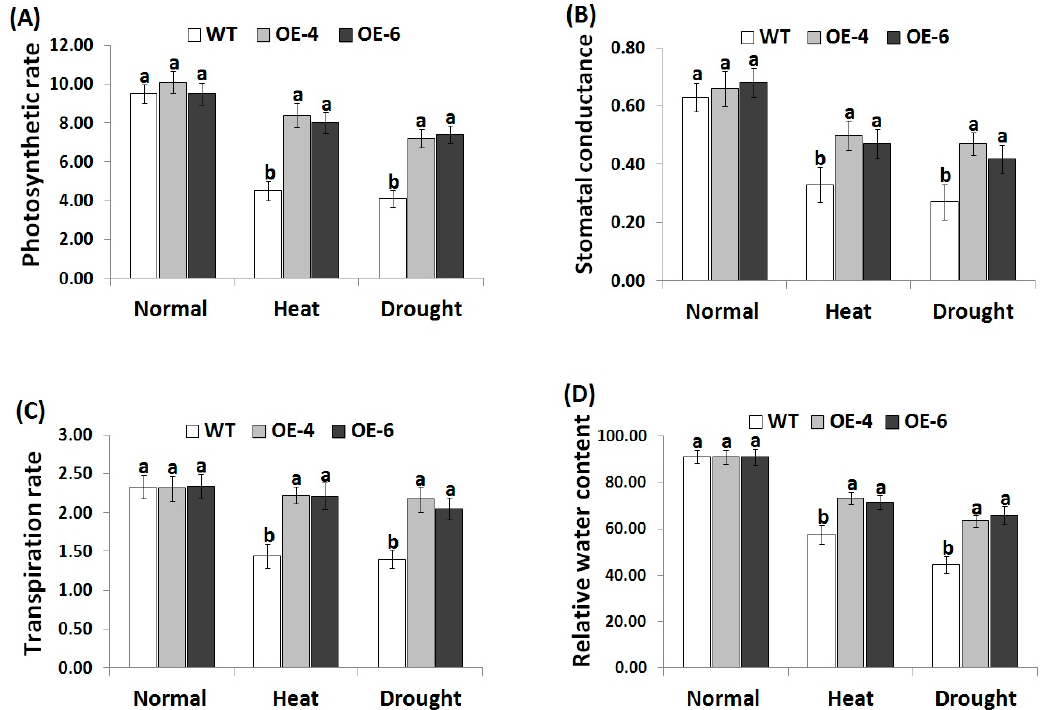
Figure 2. Photosynthesis rate ( P n , µ mol m 2 s − 1 ) ( A ), stomatal conductance ( g s , mol m 2 s − 1 ) ( B ), transpiration rate ( E , mmol m 2 s − 1 ) ( C ), and relative water content (RWC, %) ( D ) of the wild type and transgenic wheat genotypes under normal, heat, and drought stress treatments. Data indicate means ± SE ( n = 4). Different letters on the columns represent significant difference ( p ≤ 0.05).